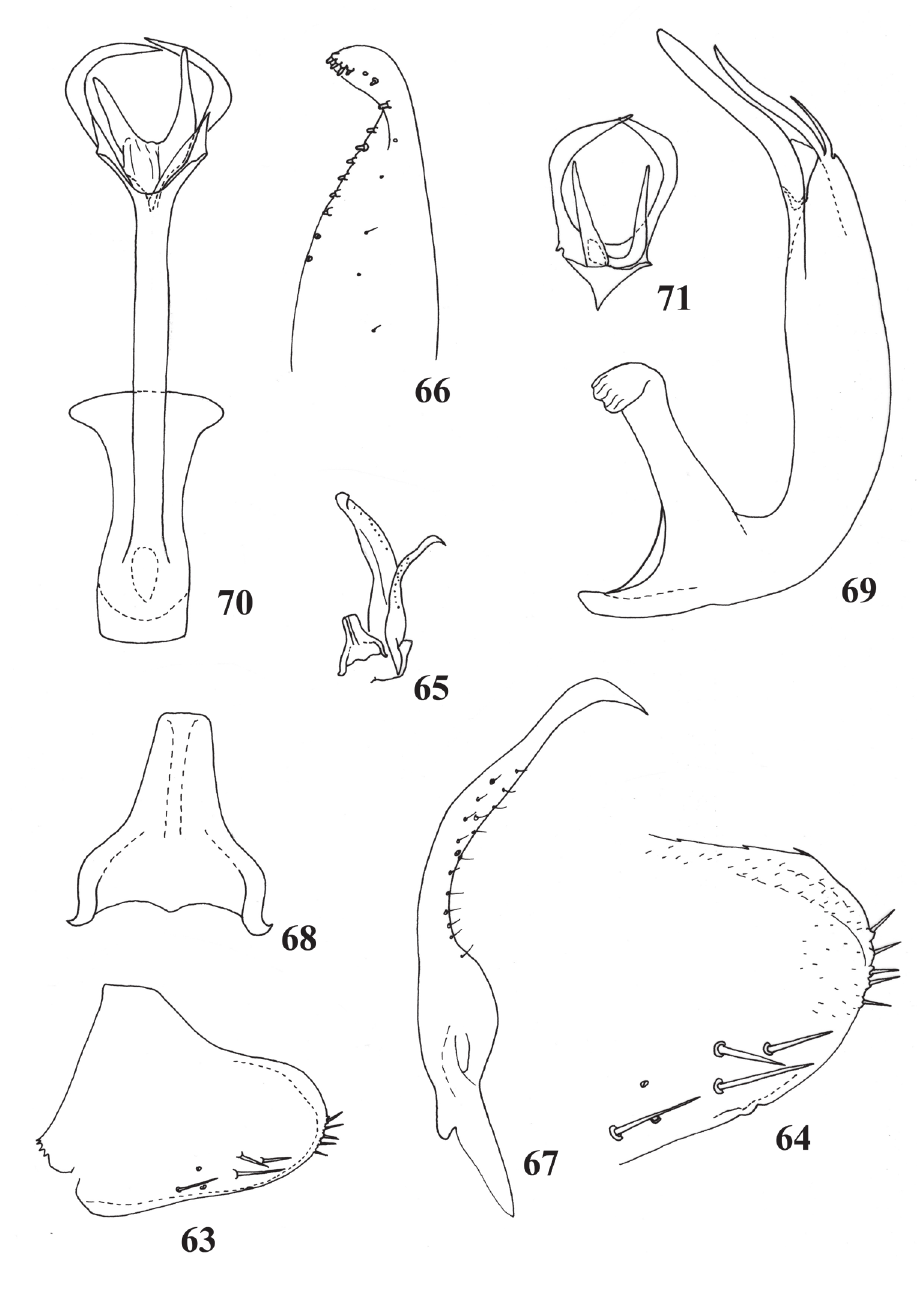
Figures 63–71. Male genitalia of Shamala annulata sp. nov. 63, 64 pygofer side, lateral view 65 paramere, connective and subgenital plate, dorsal view 66 subgenital plate 67 paramere 68 connective 69 aedeagus, lateral view 70 aedeagus, posterior view 71 apical part of aedeagus, ventral